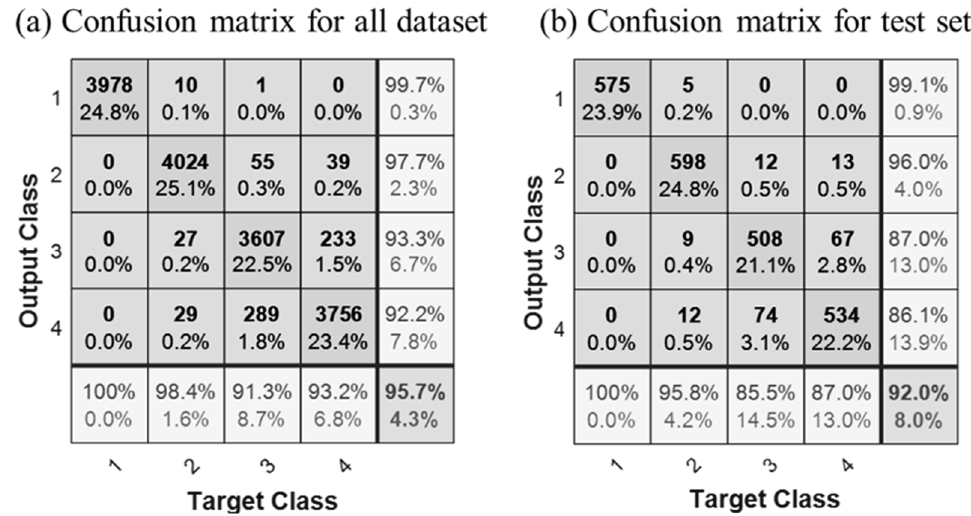
Figure 9. Confusion matrix of training performance of Network 3: ( a ) Confusion matrix for all dataset. ( b ) Confusion matrix for test set.